Question: Briefly state, in one sentence, what is plotted here.
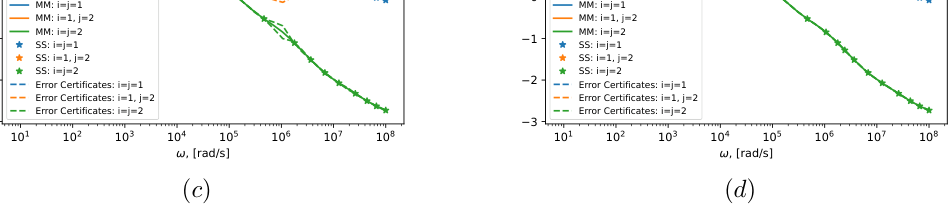
Answer: Thin conducting magnetic disk: Showing p ˜ Rqij and p ˜ R`∆qij obtained by applying the adaptive PODP Algorithm 1 at iterations paq k “ 1, pbq k “ 2, pcq k “ 3, and pdq k “ 4.